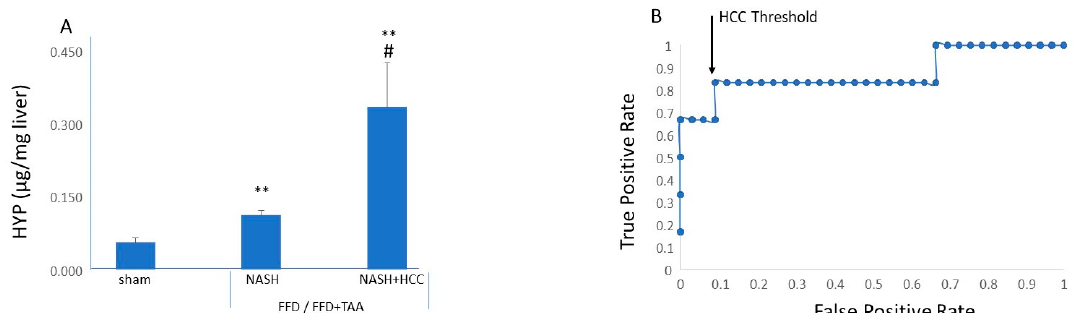
Figure 6. Liver hydroxyproline as a diagnostic for HCC. ( A ) Compared to the sham cohort, biopsies from livers characterized as NASH (FFD or FFD + TAA) had increased hydroxyproline content. ** p < 0.01 vs. sham. Hydroxyproline content was highest in biopsies from NASH + HCC livers. # p < 0.01 vs. NASH. ( B ) Receiver operating characteristics for liver hydroxyproline as a diagnostic for HCC in NASH. The threshold was selected as further improvement in sensitivity is associated with increased false positives.